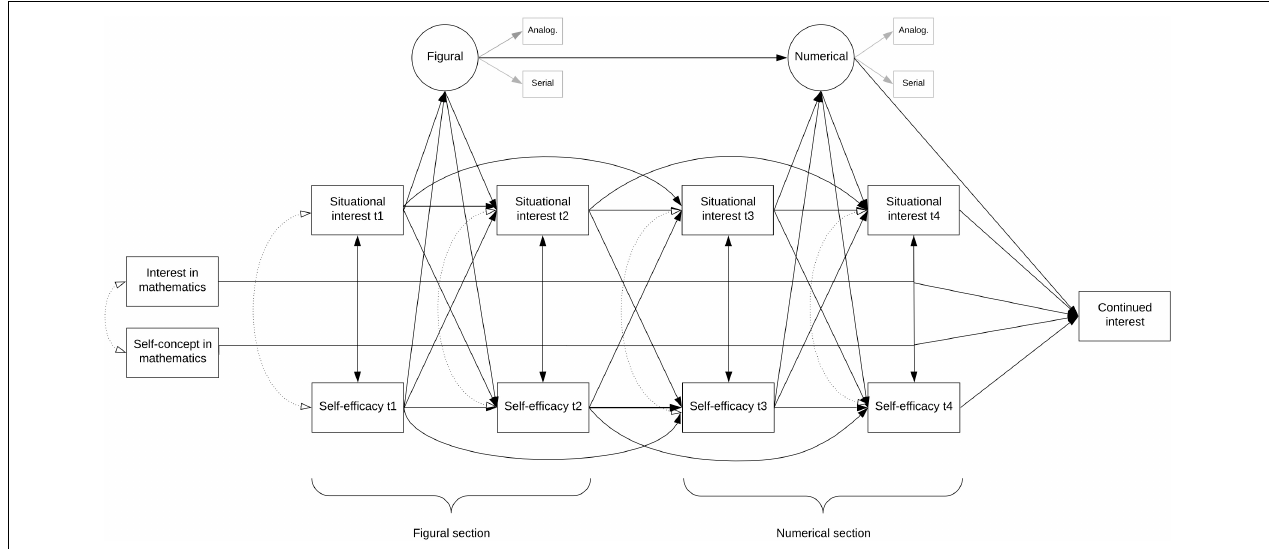
FIGURE 1 | Hypothetical SEM-model of cross-lagged reciprocal effects. Note, that gender effects specified on all variables are omitted here for the purpose of